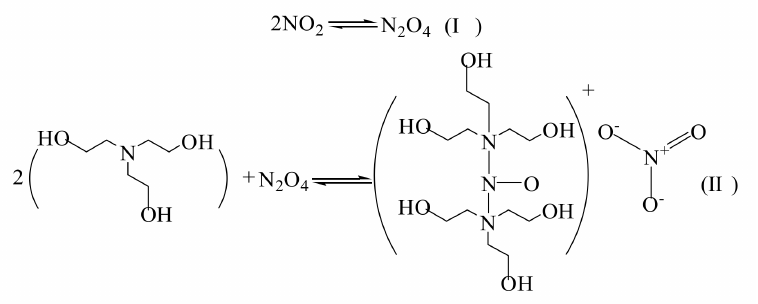
Figure 9. Speculation on reaction mechanism.